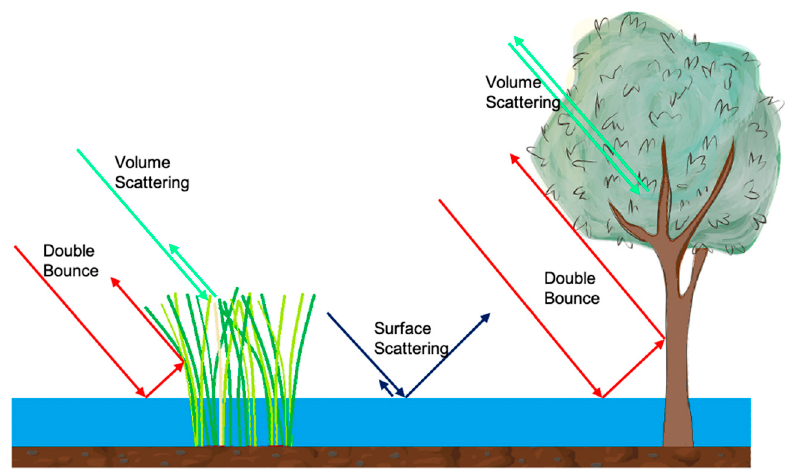
Figure 3. Scattering mechanisms in marshes (left) and swamps (right). These include volume scattering, double-bounce scattering, and surface scattering. The surface scattering is mostly specular scattering that backscatters away from the radar, due to the smooth, flat water surface (except small ripples and waves).